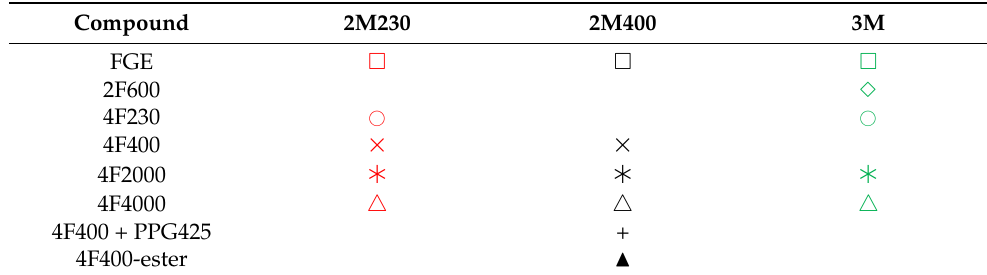
Table 1. Stoichiometric DA mixtures for the kinetic study. The symbols and colors used for the mixtures are indicated.